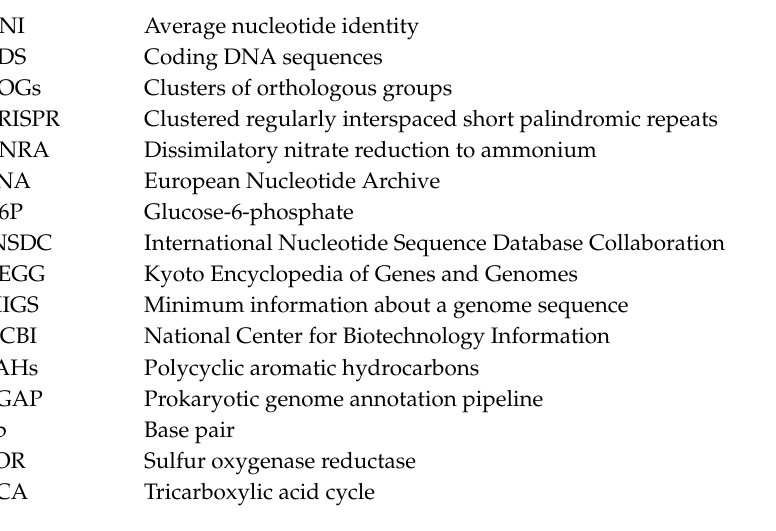
Table S1.1: Correspondences between the loci of the annotations by Prokka, Dfast, RAST, PGAP (2020-03-30. build4489) and UniProtKB with the CDSs of the NCBI’s online automated prokaryotic genome annotation pipeline, Table S1.2: Gene annotations within the genomic islands (GI) of Dissulfurirhabdus thermomarina SH388T, based on the IslandViewer 4 webserver, Figure S1.3: Homologous CDSs found by comparative genomics with the MaGE platform among the genomes of the hydrothermal bacteria Thermosulfurimonas marina , Thermosulfuriphilus ammonigenes , Dissulfuribacter thermophilus , and Thermosulfurimonas dismutans , excluding homologous CDSs from the genome of D. thermomarina